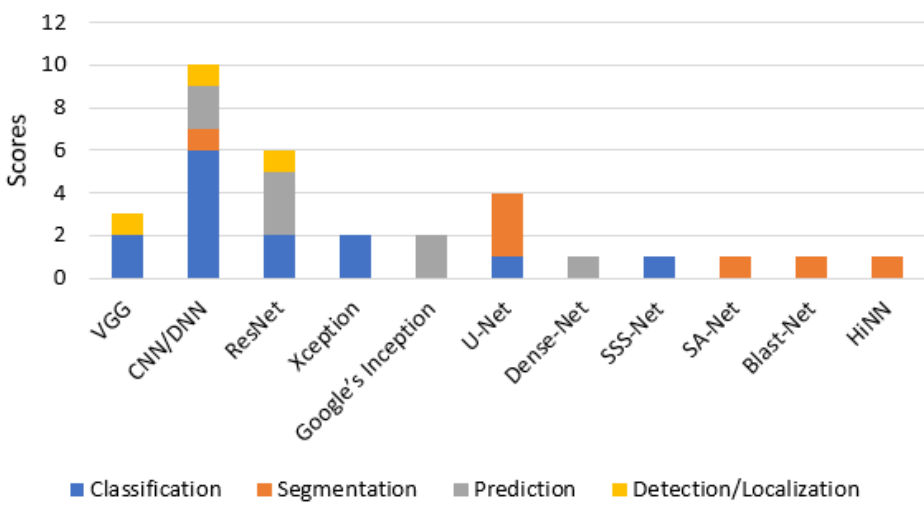
Figure 7. Score distribution of various deep learning models employed in blastocyst study.